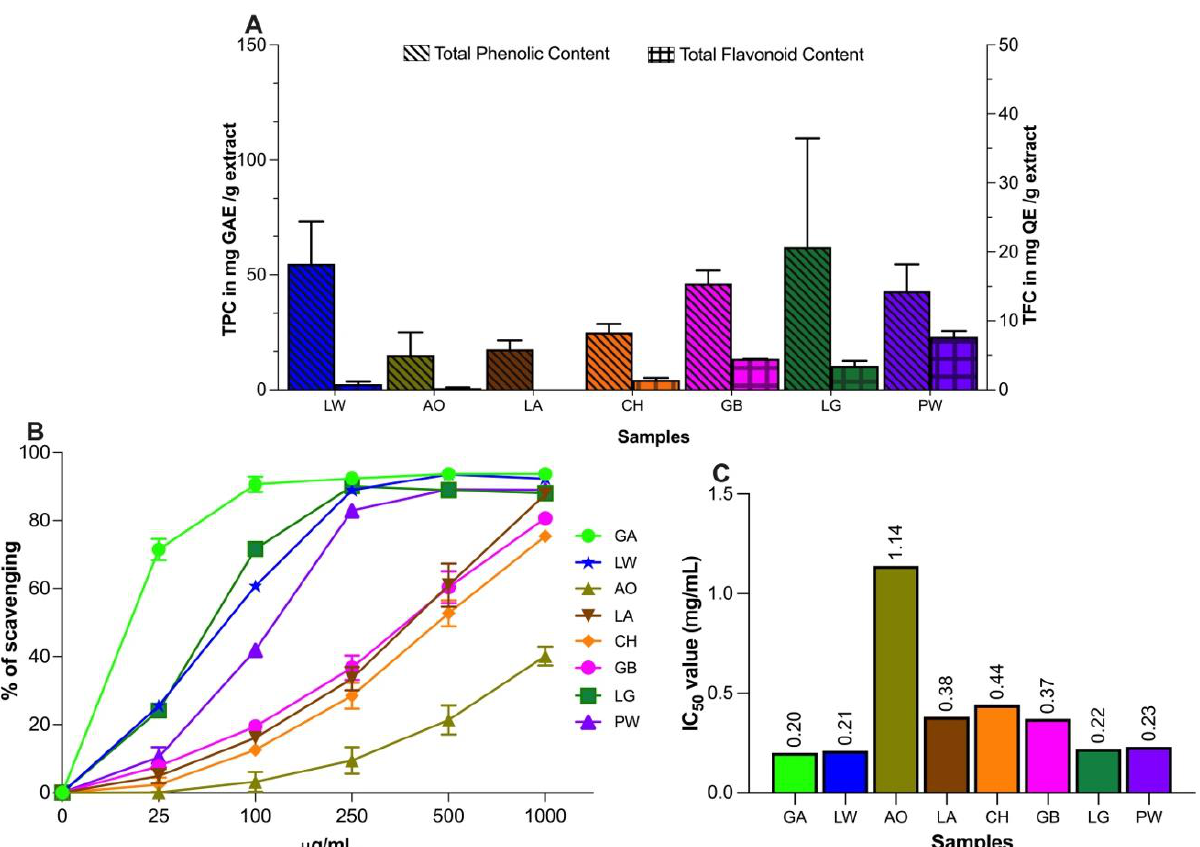
Figure 1. Phytochemical content and antioxidant activities of seven Wet Tropics plant extracts. ( A ) Phenolic and flavonoid content. ( B ) DPPH free radical scavenging activity at various concentrations compared with standard gallic acid. ( C ) The IC 50 value (mg/mL) of DPPH free radical scavenging activity. All values are expressed as mean ± SD from two separate experiments (n = 3). GA — gallic acid (reference compound); LW — Leptospermum wooroonooran ; AO — Alyxia orophila ; LA — Linospadix apetiolatus ; CH — Ceratopetalum hylandii ; GB — Garcinia brassii ; LG — Litsea granitica ; PW — Polyscias willmottii